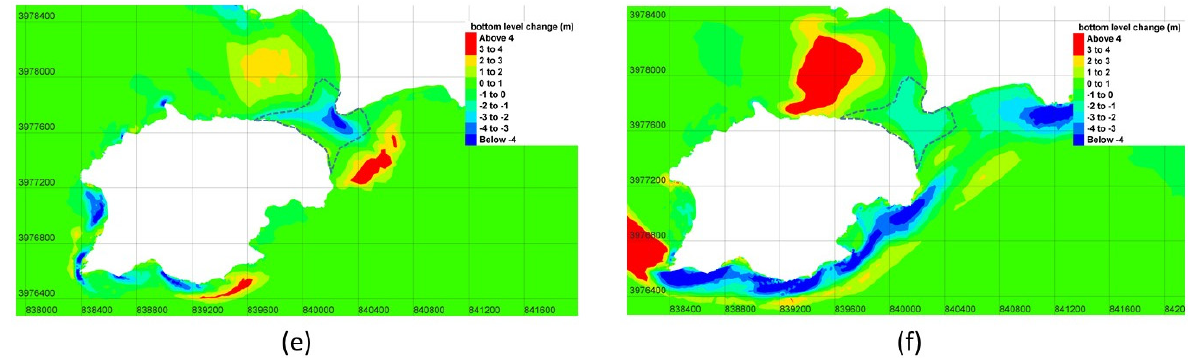
Figure 18. Maps of Hm0 (m), current velocity (m/s), and bottom level change (m) in the sea area of interest for extreme wind–wave scenario 5 ( a , c , e ) and for extreme wind–wave scenario 6 ( b , d , f ), respectively. The dotted closed line encloses the active domain of the study area for salient formation. Maps created in Blue Kenue™ software tool for hydraulic modellers.